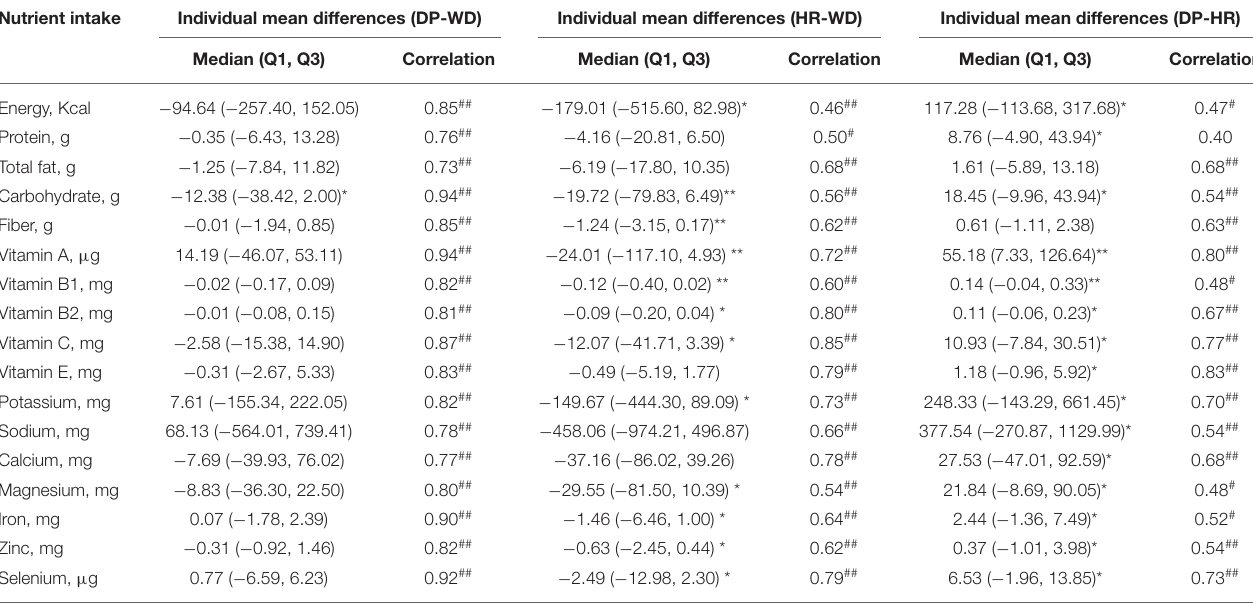
TABLE 1 | The differences and associations of daily intakes of energy and nutrients recorded in the 24h dietary recall (HR), diet photography record (DP), and weighed dietary record (WD) in the preschoolers from southwest China ( n = 40). Nutrient intake Individual mean differences